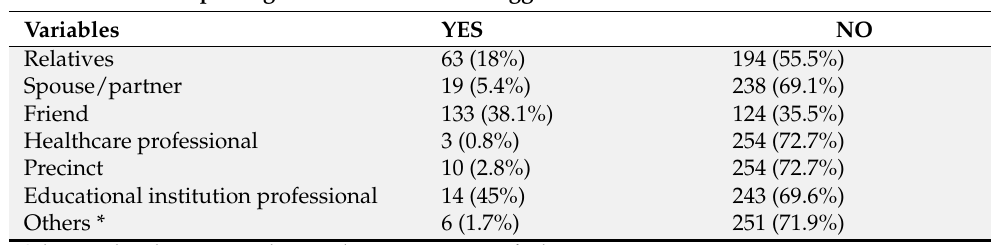
Table 3. Reporting the discrimination experienced among men who have sex with men in Bel é m, Par á , Brazil, 2016.